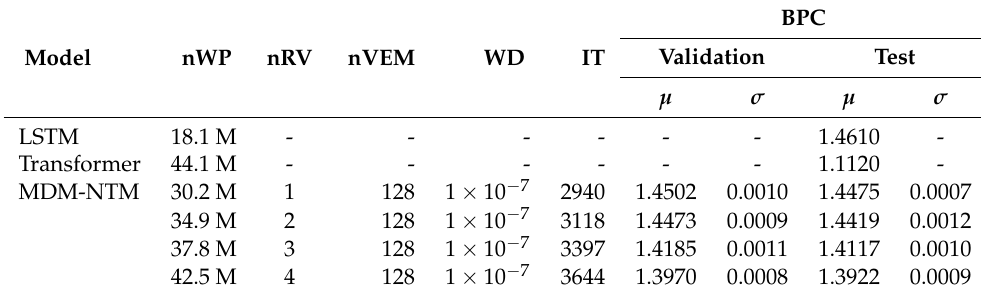
Table 3. Evaluation results of MDM-NTM-based LMs on the enwik8 LM task (nWP, number of weight parameters; nRV, number of read vectors; nVEM, number of vectors in the external memory; WD, weight decay; IT, inference time (ms/batch); µ , mean of BPC results; σ , standard deviation of BPC